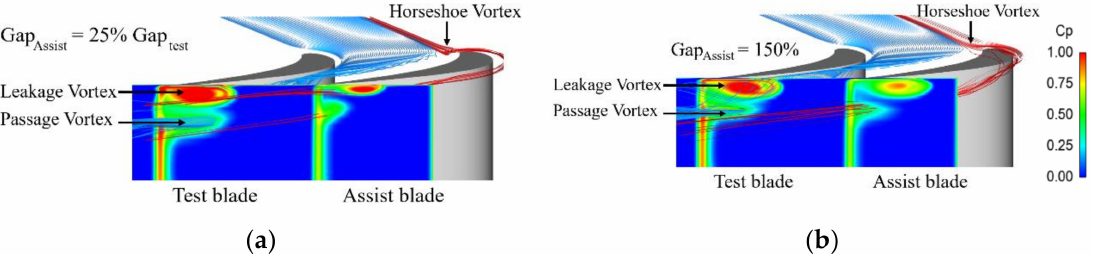
Figure 5. 3D flow field for two assist blade tip gap cases: ( a ) Gap Assist = 25% Gap Test and ( b ) Gap Assist = 150% Gap Test